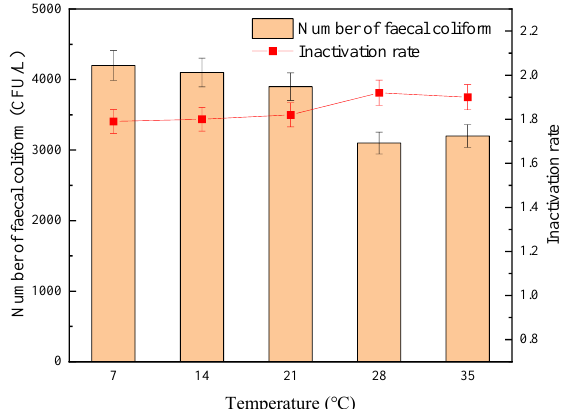
Figure 11. The effect of temperature on the sterilization effect of “ Method B” .